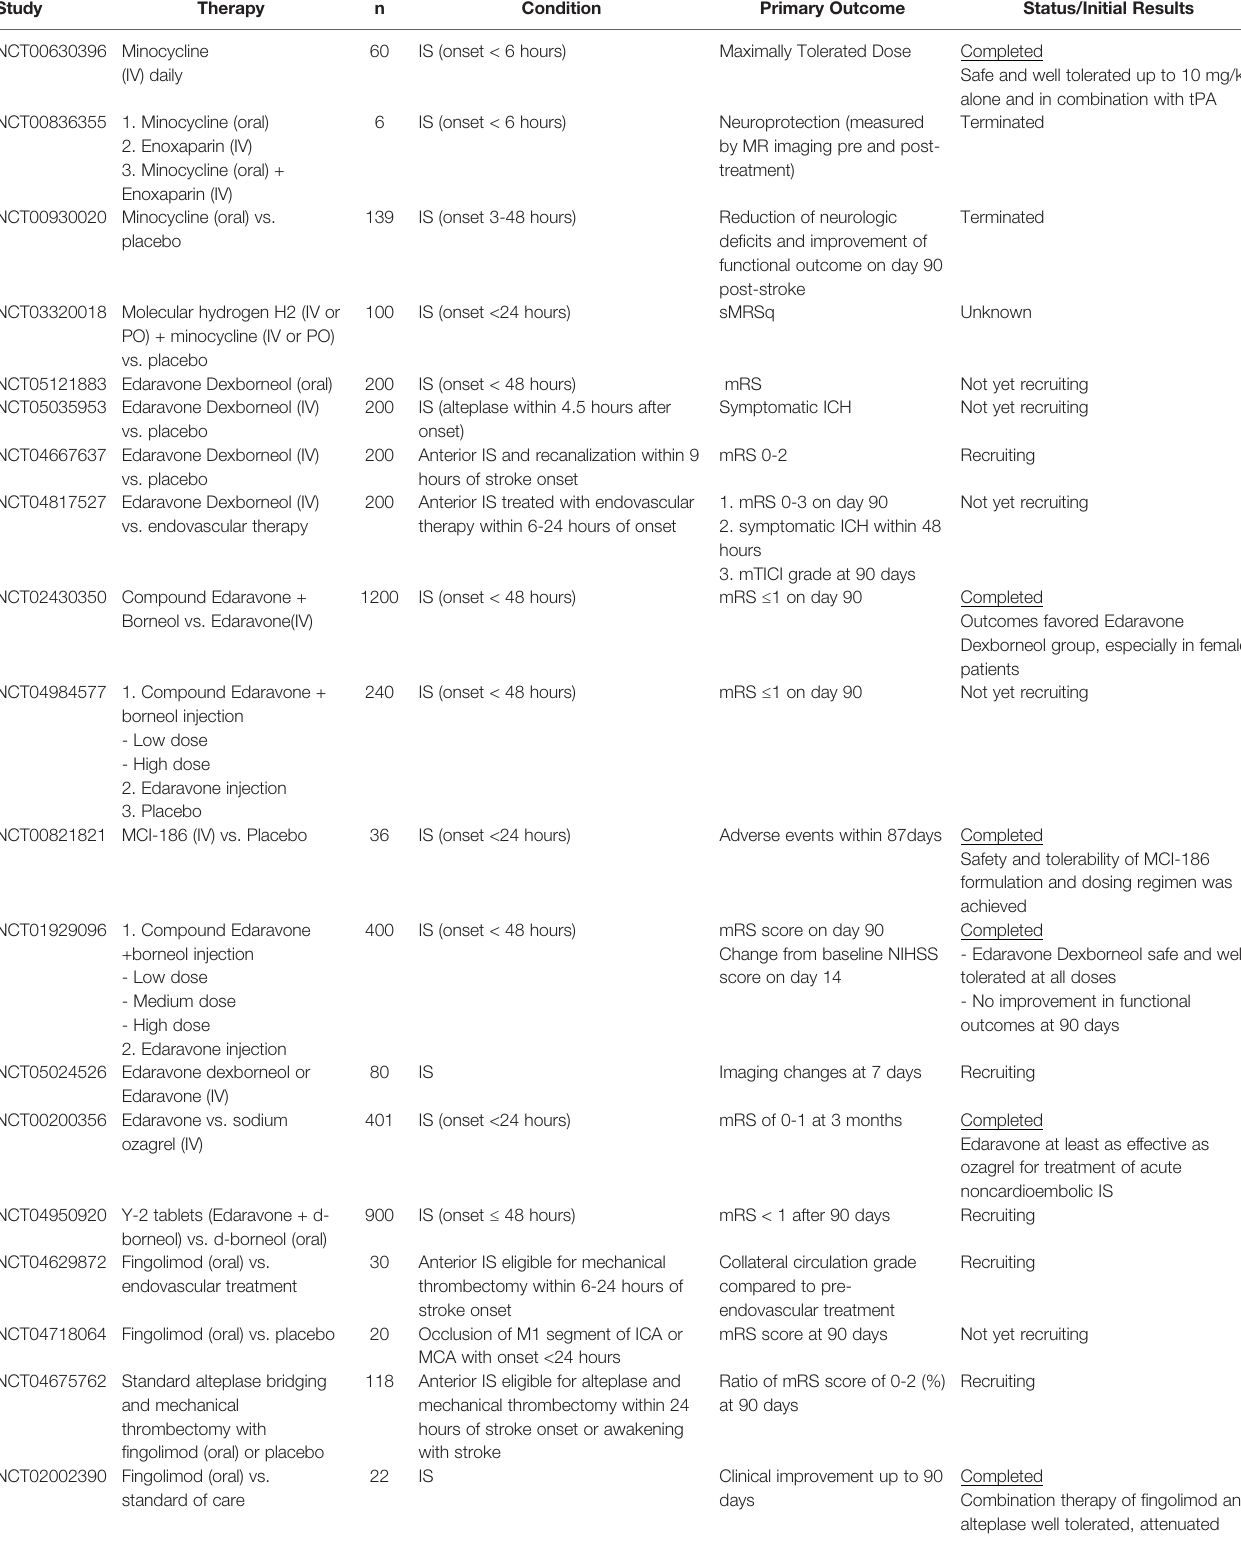
TABLE 2 | Clinical Studies Investigating Microglia Phenotype